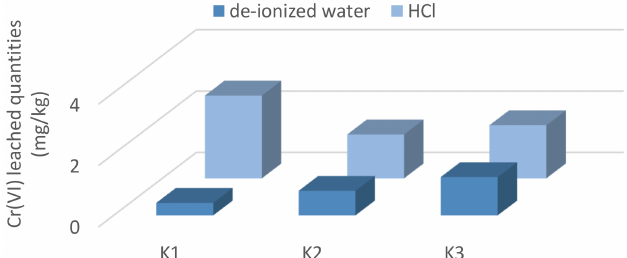
Figure 3. A comparison of the Cr(VI) leached quantities from composites in deionized water and HCl after the 90-day leaching.